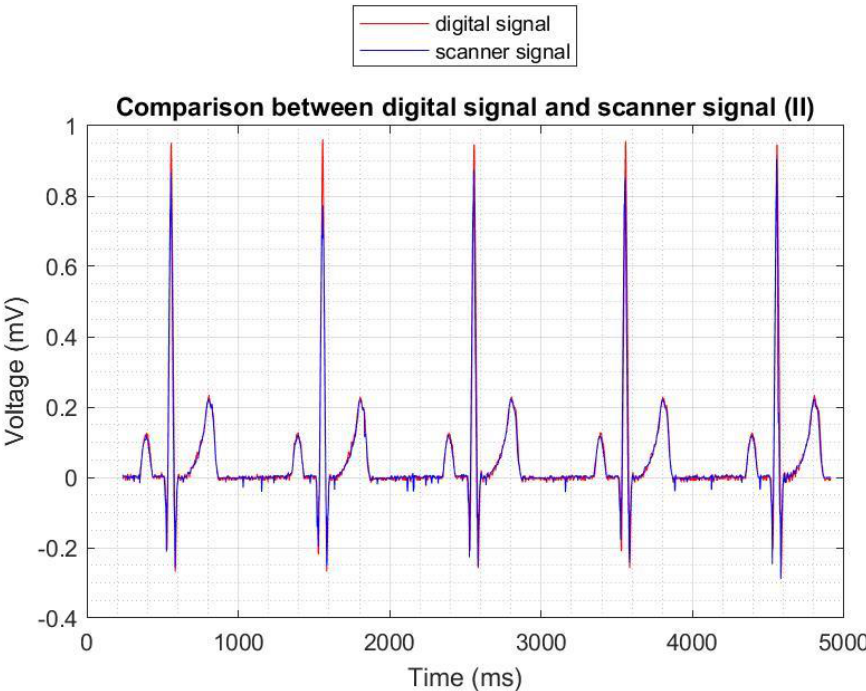
Figure 15. Comparison between the digitized ( blue ) and digital ( red ) signal for lead II (Normal sinus rhythm, 60 bpm).